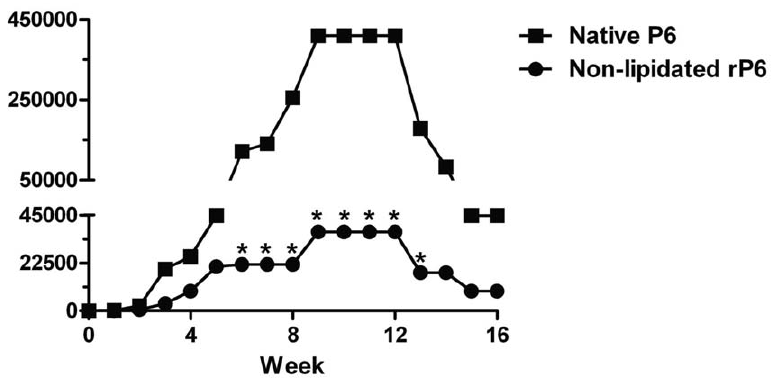
N Figure 1. Anti-P6 Ig levels are elevated in mice immunized with P6 expressing lipid motif. Mice were immunized i.p. at one week intervals ) emulsified in CFA, IFA, and PBS. Anti-P6 Ig levels were measured in pre-immune and post- with 40 m g of native P6 ( & ) or non-lipidated rP6 ( immune sera by ELISA. Results are expressed as endpoint titers of serum dilutions. *p , 0.05 2way ANOVA with Bonferroni post-test comparison between native P6 and non-lipidated rP6 at each timepoint.